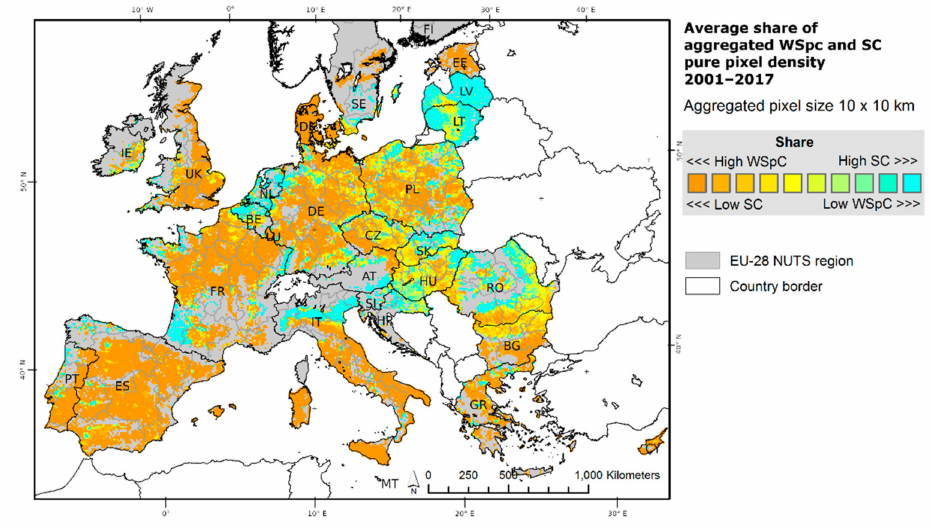
Figure 3. Average share of the WSpCs and SCs pure pixel density from 2001–2017 over arable land, aggregated to a pixel size of 10 × 10